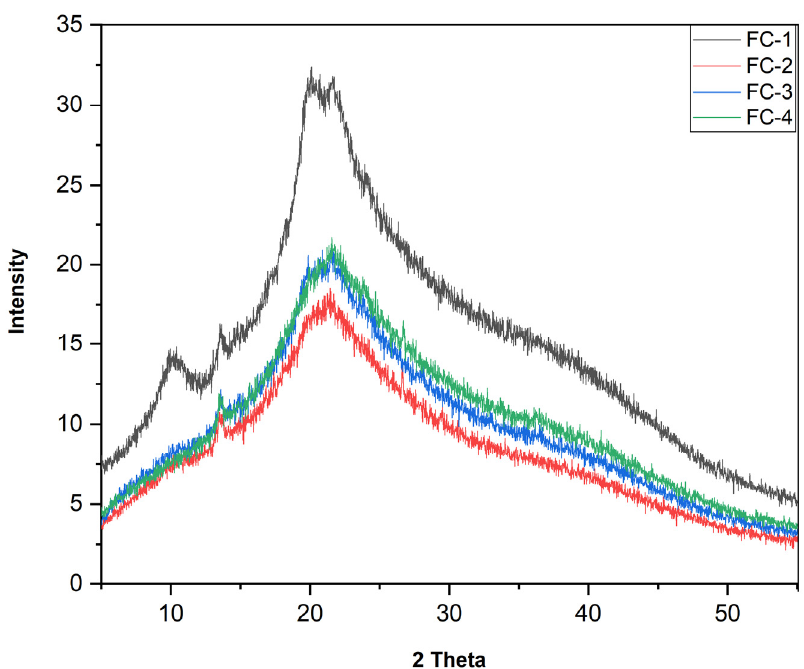
Figure 2. XRD of CS–SA edible film samples, control or FC-1, CS + SA; FC-2, CS + SA + FFE (0.5%); FC-3, CS + SA + FFE (1%); and FC-4 CS + SA + FFE (1.5%).